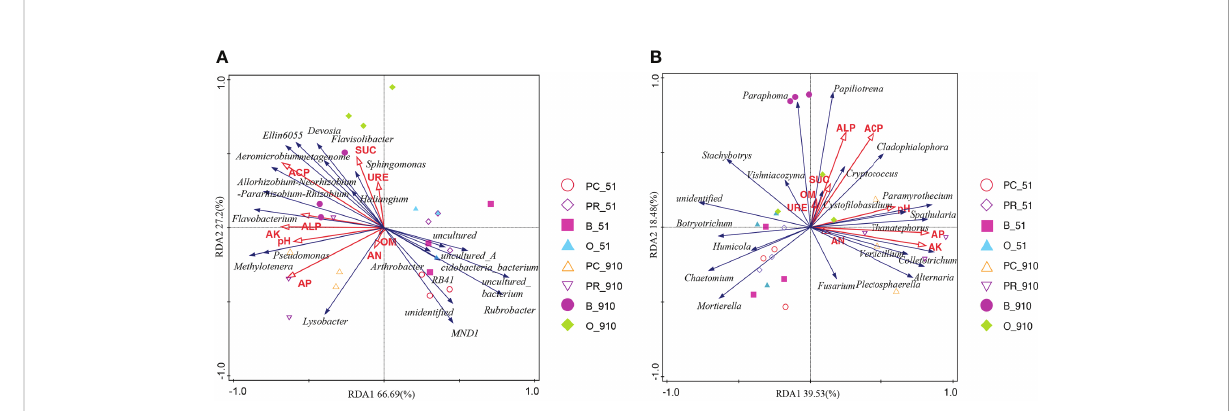
FIGURE 6 Redundancy analysis (RDA) of bacterial (A) and fungal (B) communities (genera) and soil biochemical properties. B_51, O_51, PC_51 and PR_51 indicate the samples from B, O, PC and PR treatments at pre-planting, respectively; B_910, O_910, PC_910 and PR_910 indicate the samples from B, O, PC and PR treatments at harvest.